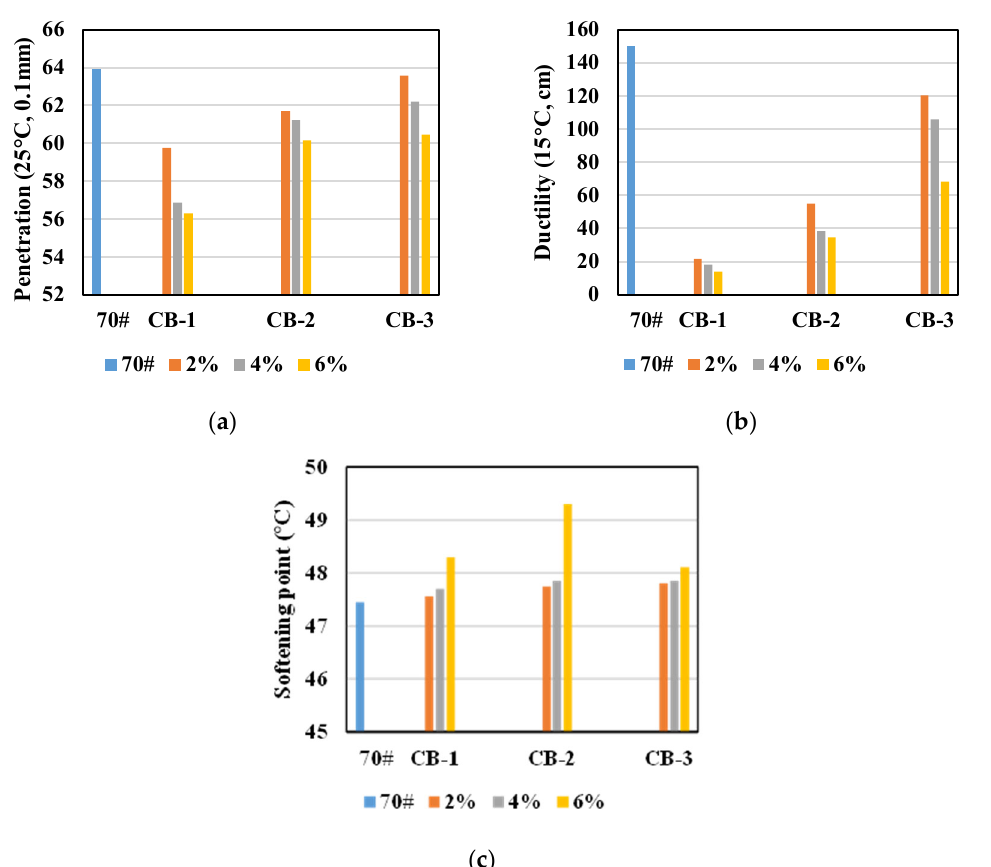
Figure 2. Physical properties of asphalt: ( a ) penetration; ( b ) ductility; ( c ) softening point.